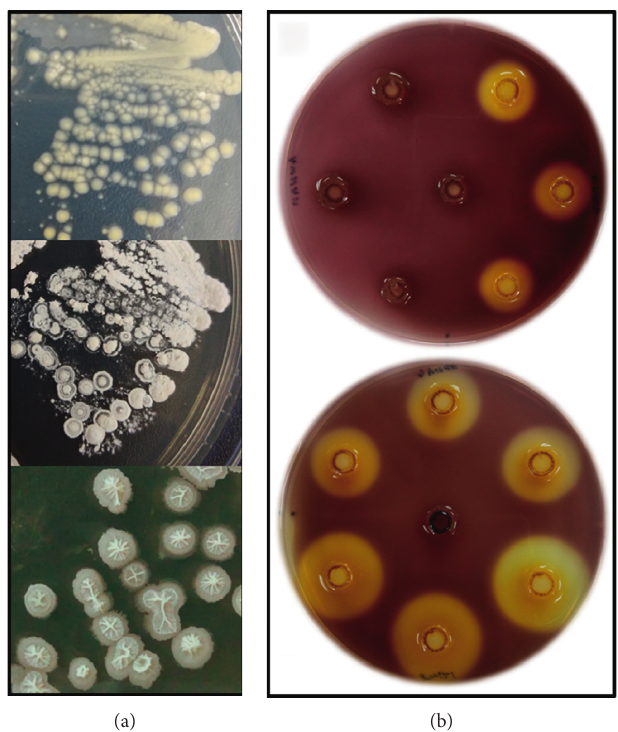
Figure 1: Representative colony morphology of isolated colonies and plates showing cellulolytic activity of isolates. (a) Bacterial isolates showing the typical characteristic of actinomycetes. (b) Representative plates of the cellulolytic activity of selected isolates in CMC agar flooded with Gram’s iodine showing isolates with clearance zone diameters of at least 20mm and with clearance zone diameters lower than 20mm. The middle imprints on both plates are negative controls showing no clearance